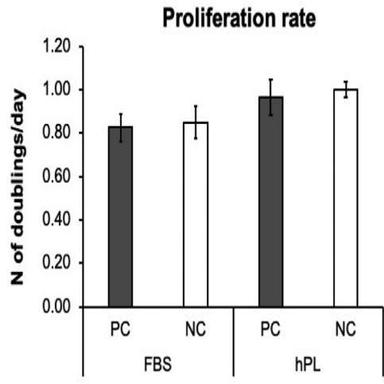
Proliferation rate of NC and PC expanded for two passages in medium containing 5% FBS or 5% hPL. Values are mean § standard deviation of three independent experiment using cells from three different donors.